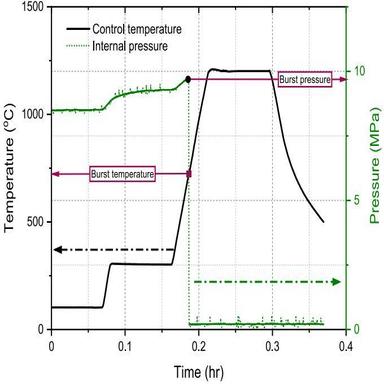
Typical temperature and pressure histories imposed to specimens in this study (similar to a simulated LOCA event.